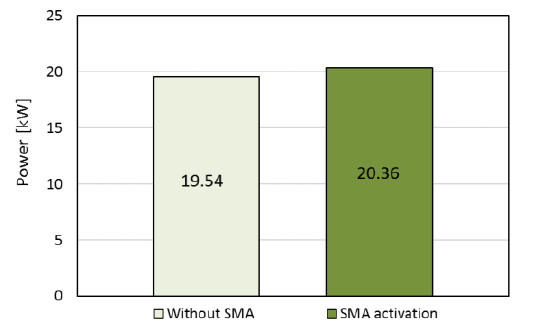
Fig. 15. Average power required for hovering